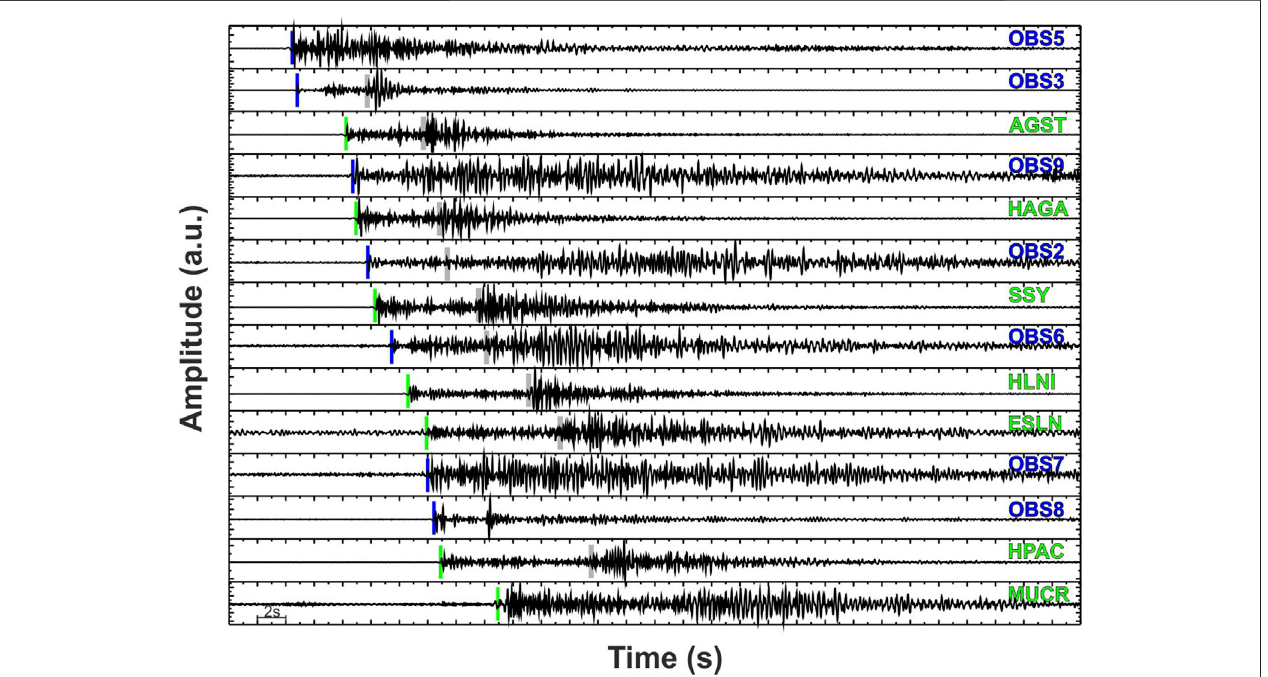
FIGURE 4 | Example of seismic waveform (vertical component) for the local events occurring on October 23, 2017 h 19:11 UTC (M L (cid:2) 2.8) and recorded by both land network (a sample of travel times from land stations is represented) and OBS network. The blue and green bars represent the P-phase picked on OBSs and land stations,respectively; grey bars represent theS-phases, picked on horizontal components for both OBSs and land stations. Parameters oflocation performed with and without the use of OBSs for this event are listed in Supplementary Tables 1 – 2 .